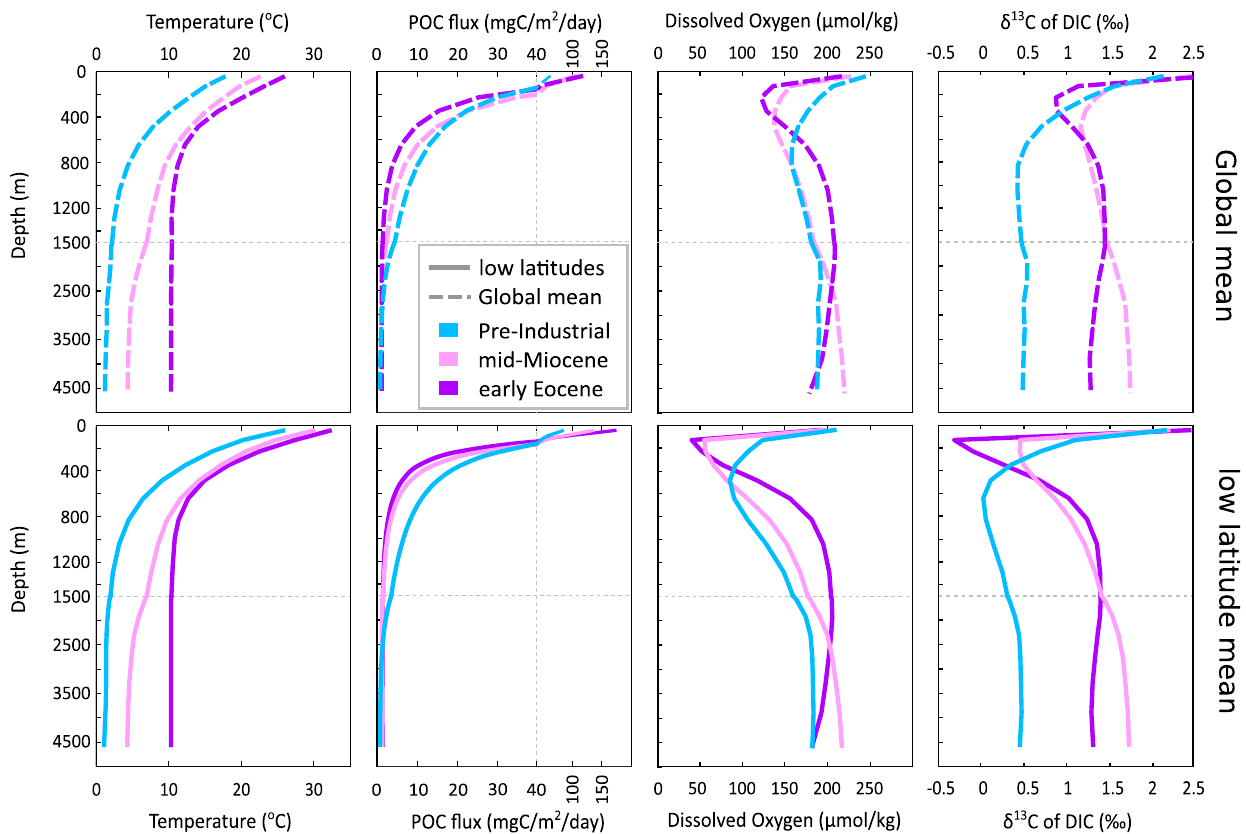
Fig. 2 | Modeled water column pro fi les for the early Eocene (purple), mid- Miocene (pink), and preindustrial present (blue). From left: temperature, parti- culate organic carbon (POC), dissolved oxygen, and δ 13 C of DIC (dissolved inor- ganic carbon) for early Eocene (55Ma), mid-Miocene (15Ma), and